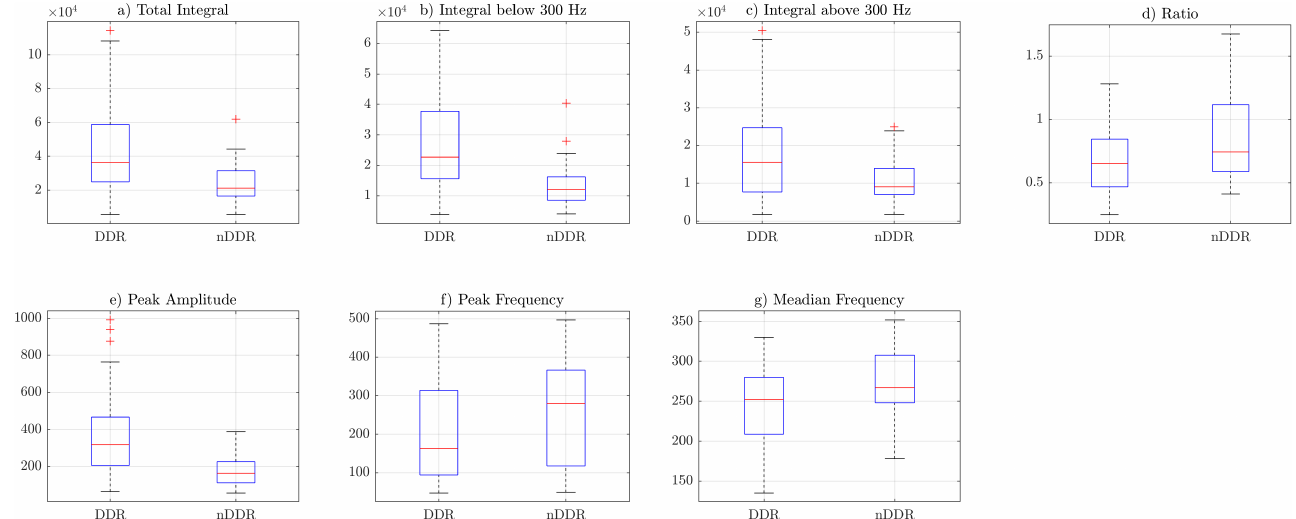
Figure A5. Box plots of norm2 features obtained for the first measurement: ( a ) TI feature, ( b ) IB3 feature, ( c ) IA3 feature, ( d ) IBAR feature, ( e ) PA feature, ( f ) PF feature, ( g ) MF feature.